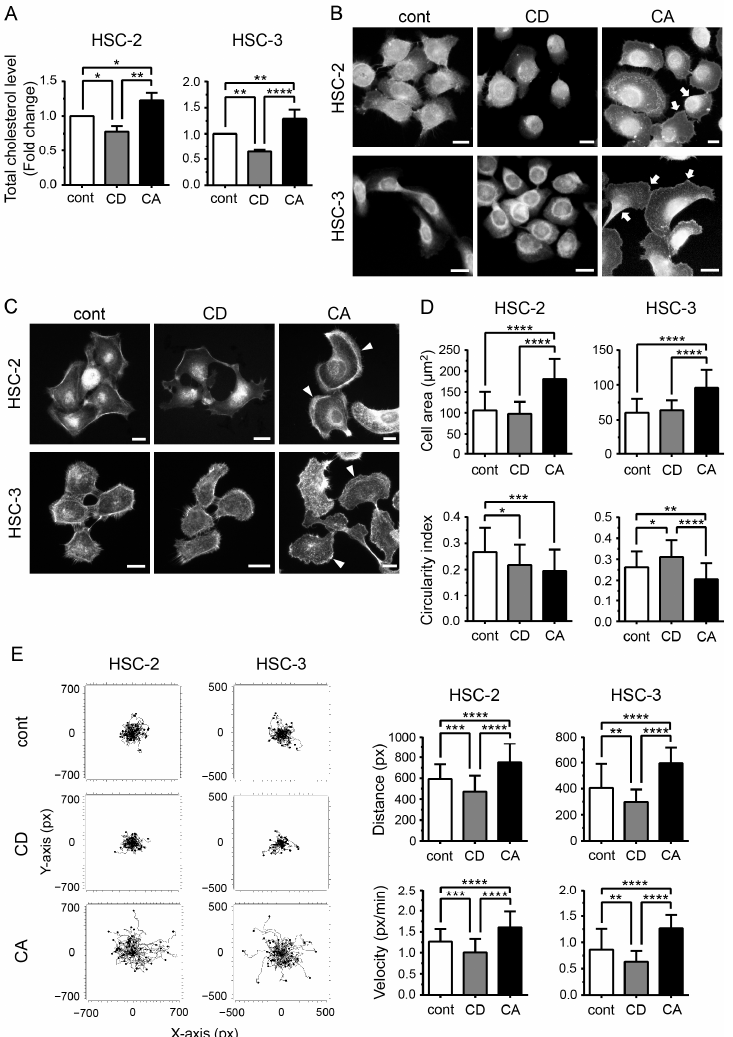
Figure 1. Cholesterol influences cell morphology and promotes cell migration. ( A ) Quantifica- tion of total cellular cholesterol levels using Amplex TM Red cholesterol assay. Open boxes indi- cate control (cont); gray-shaded boxes indicate cholesterol-depleted (CD) cells; solid boxes indi- cate cholesterol-added (CA) cells. Triplicate results of cholesterol levels represent fold change as mean ± SD (compared to control). * p < 0.05, ** p < 0.01, and **** p < 0.0001. ( B ) Fluorescence staining using a filipin III cholesterol probe. Scale bars, 20 µ m. Arrows indicate high filipin III signaling at the periphery of the cells. ( C ) Fluorescence images of F-actin visualized by rhodamine-phalloidin staining to evaluate cellular morphology. Scale bars, 20 µ m. Arrowheads indicate the development of a lamellipodia-like structure. ( D ) Bar graphs showing cellular area and circularity index (N ≥ 50) expressed as mean ± SD. * p < 0.05, ** p < 0.01, *** p < 0.001, and **** p < 0.0001. ( E ) Cell-tracking plots of timelapse imaging for 8 h (N ≥ 50). Distance and velocity are analyzed using chemotaxis and migration tools (ibidi) and expressed as mean ± SD. ** p < 0.01, *** p < 0.001, and **** p <